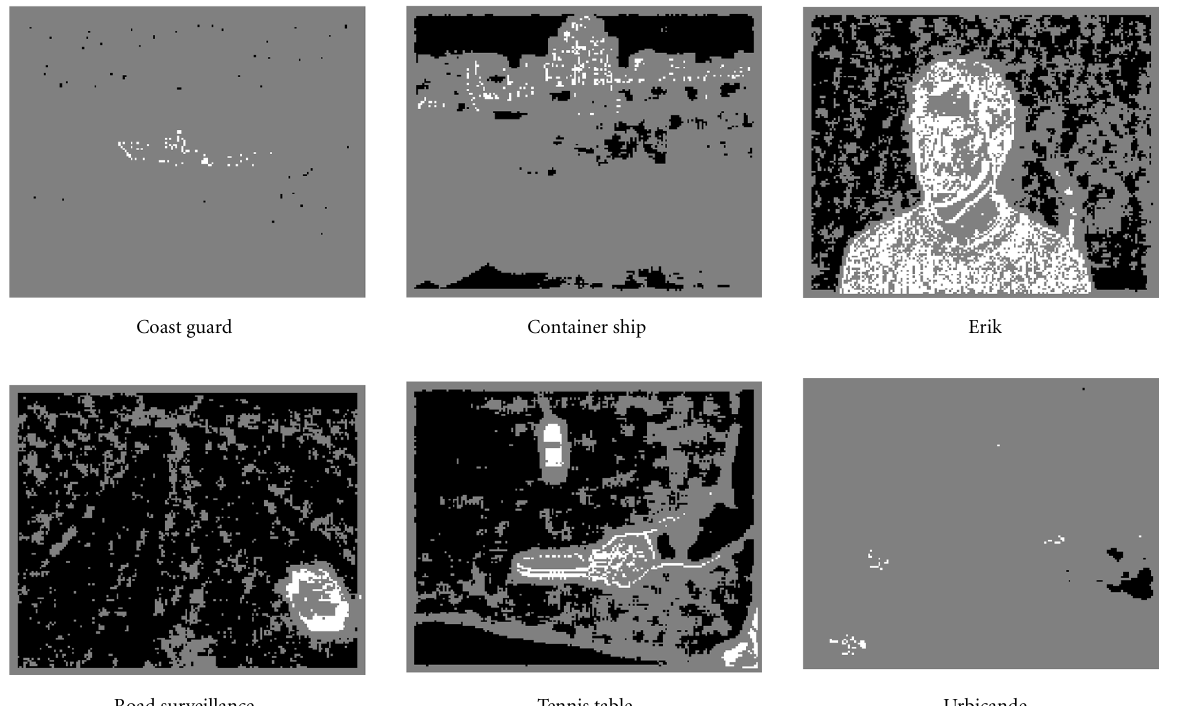
Figure 2: Initial labelled